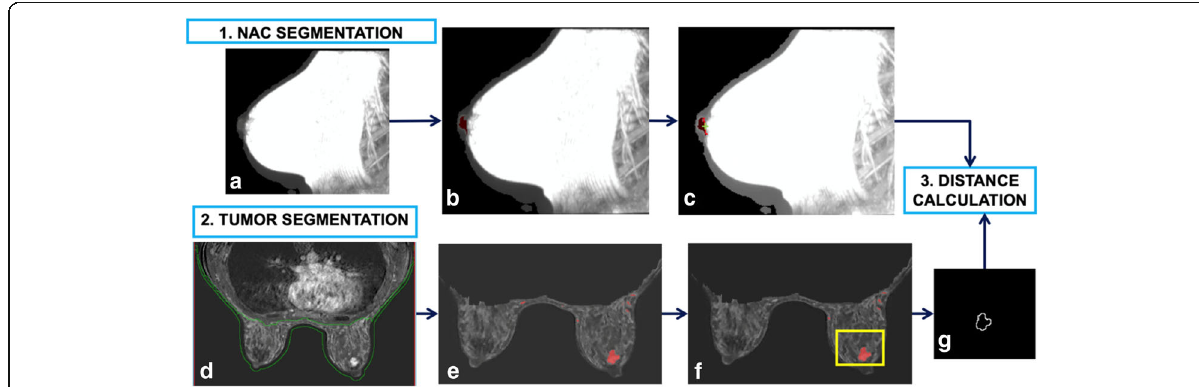
Fig. 2 Pipeline of the segmentation algorithm. a Maximum intensity projection (MIP) of the T2-weighted dataset. b Segmentation of the nipple-areola complex (NAC) superimposed to the T2-weighted MIP. c B-spline curve that represents the base of the NAC superimposed to the T2-weighted MIP (the point used to compute the distance is highlighted by using a green cross). d Segmentation of the breasts superimposed to the second subtracted contrast-enhanced frame. e Segmentation results before applying the false-positive reduction step. f Segmentation results after applying the false-positive reduction step (the yellow box represent the region that the radiologist selected as tumour). g The outer edge of the selected tumour